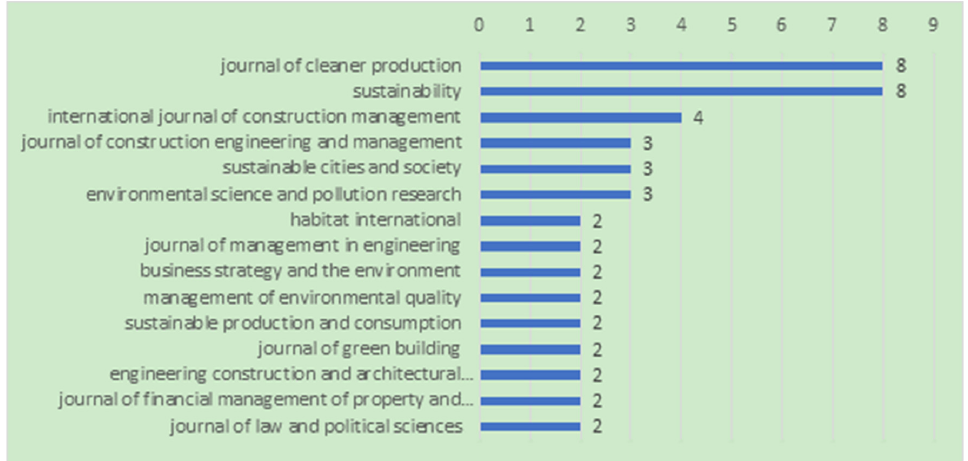
Figure 3. TOP 15 journals in CGCC by publication number. Note: The Y-axis represents the different journals and the X-axis represents the number of publications published in each